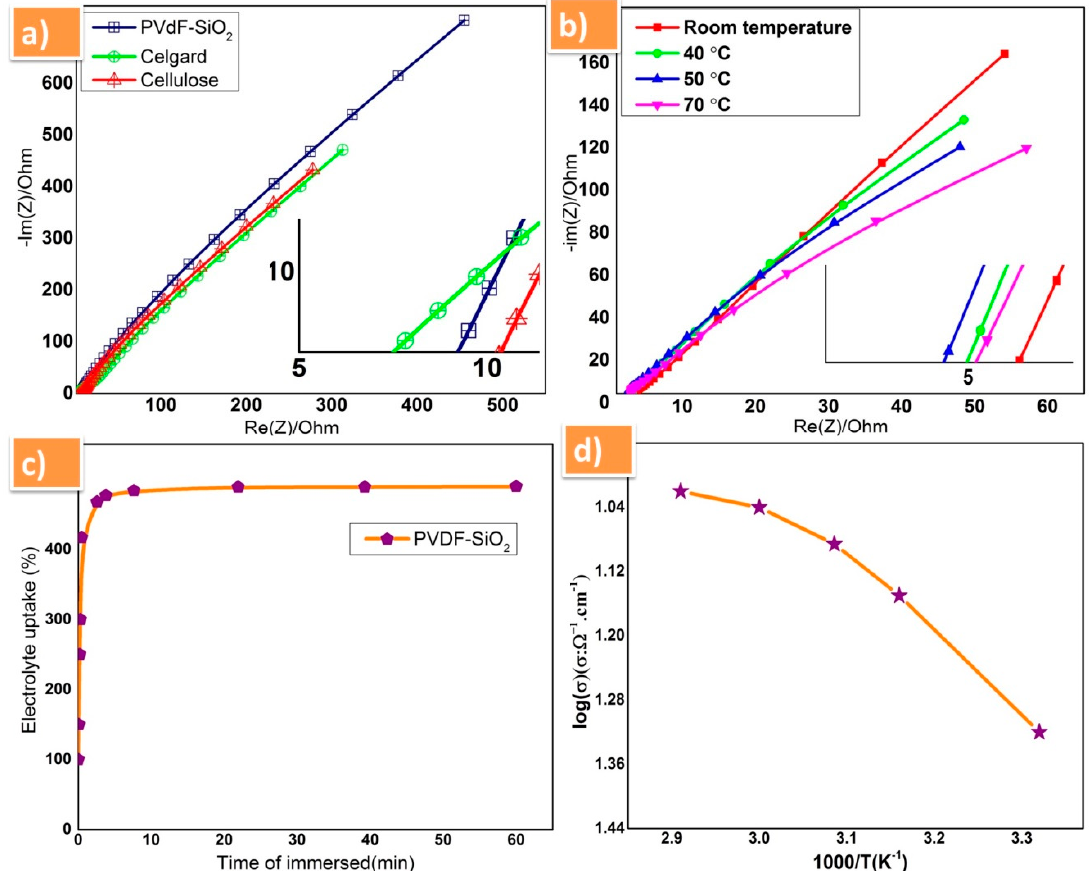
Figure 4. ( a ) Complex impedance spectra of PVdF-SiO 2 , celgard, and cellulose membranes at room temperature; ( b ) ionic conductivity of PVdF-SiO 2 membrane with different values temperature; ( c ) plot of electrolyte uptake with time; and ( d ) temperature-dependent ionic conductivity plot of PVdF-SiO 2 membrane. Table 1. Ionic conductivity PVdF-SiO 2 with commercially available